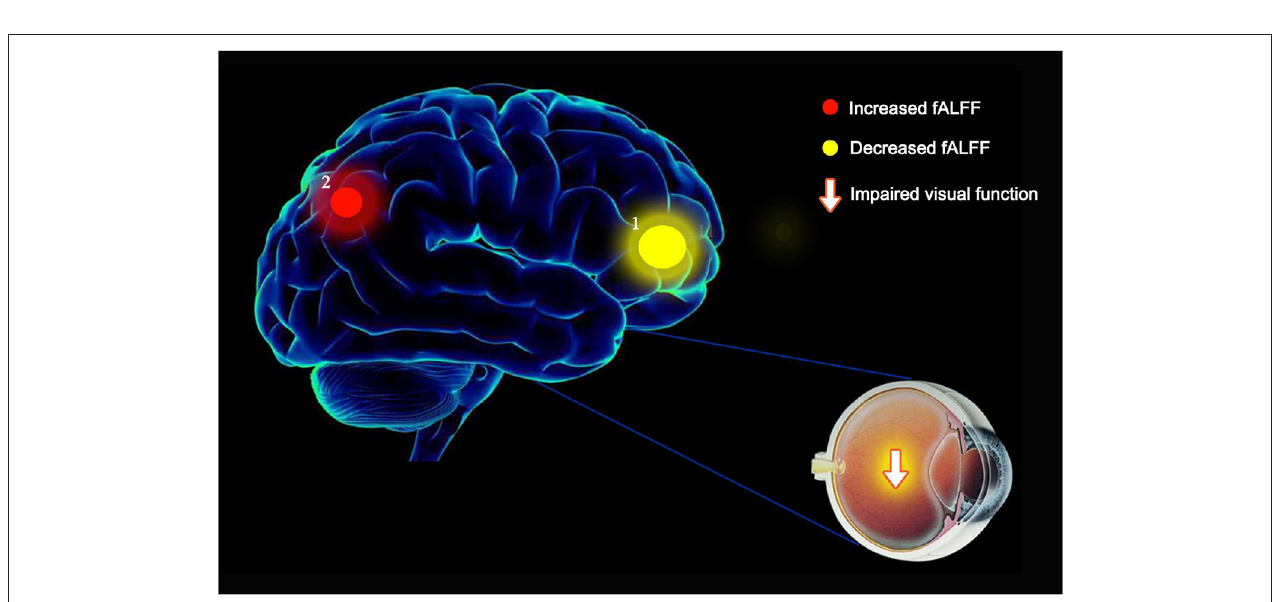
FIGURE 4 | ROC curve analysis of the mean fALFF values of the two brain regions in two groups. (A) The areas under the ROC curve were: LAC 0.990, ( P < 0.001; 95%CI,0.967-1.000), (B) The areas under the ROC curve were: LP 0.884 ( P < 0.001; 95%CI,0.775-0.994). ROC, receiver operating characteristic; fALFF, fractional amplitude of low-frequency fluctuations; ALFF, amplitude of low-frequency fluctuation; CI, confidence interval; AUC, area under the curve;LAC, left anterior cingulate; LP, left precuneus.